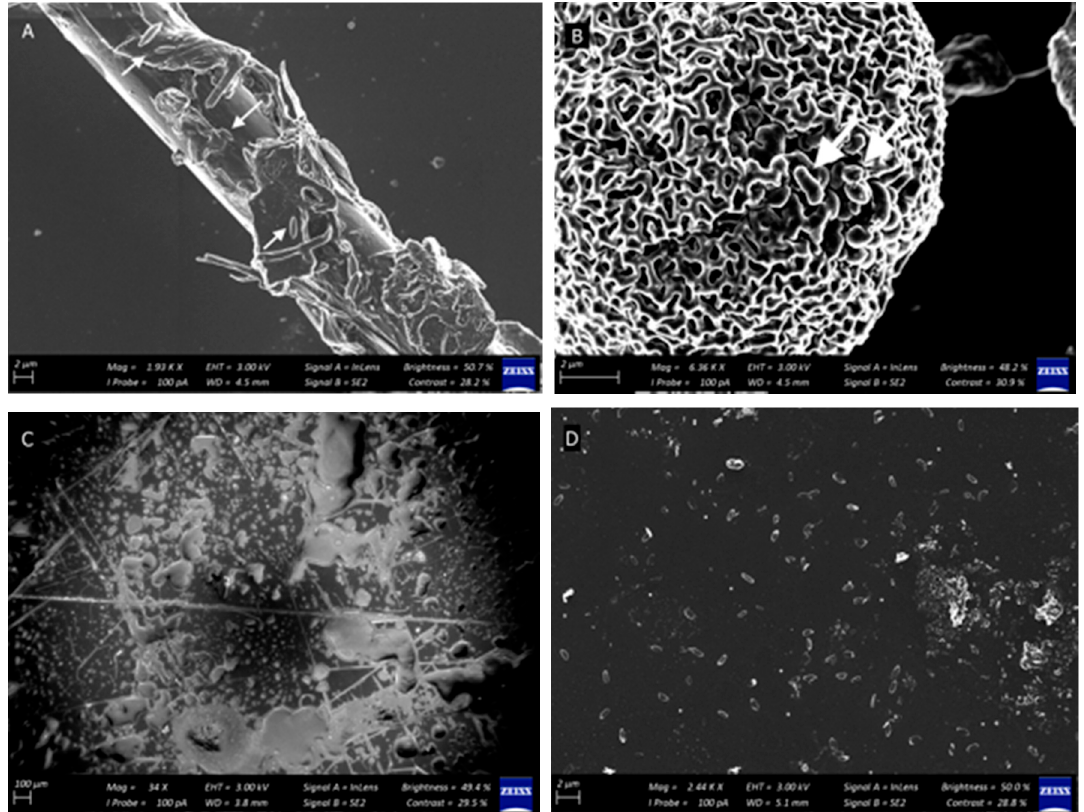
Figure A1. Qualitative SEM observations of cells associated with particulate matter on linoleum surfaces subjected to the cleaning regimes, including ( A ) fabric thread, and ( B ) pollen grains. Cells are indicated with arrows. Surface damage (scratches and indentations) are clear on disinfectant-treated surfaces at higher magnifications ( C ) (100 μ m) as compared with surfaces washed with tap water ( A ) (control), soap ( B ), and probiotic soap ( D ). Bacillus spores are present in abundance on all surfaces treated with probiotic soap (D).